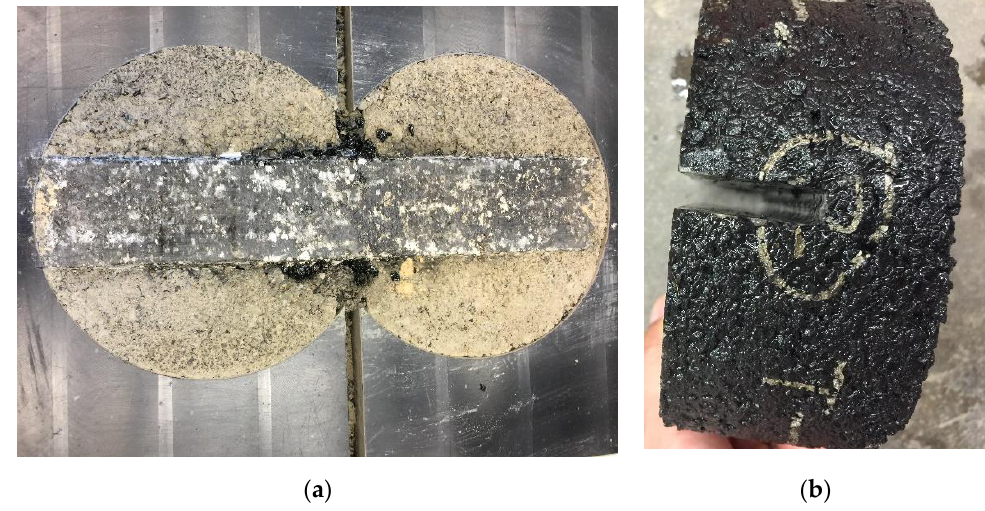
Figure 12. Specimen #9 (2.4-inch thickness, 10 days aging, with a notch), ( a ) specimen top and ( b ) specimen bottom.